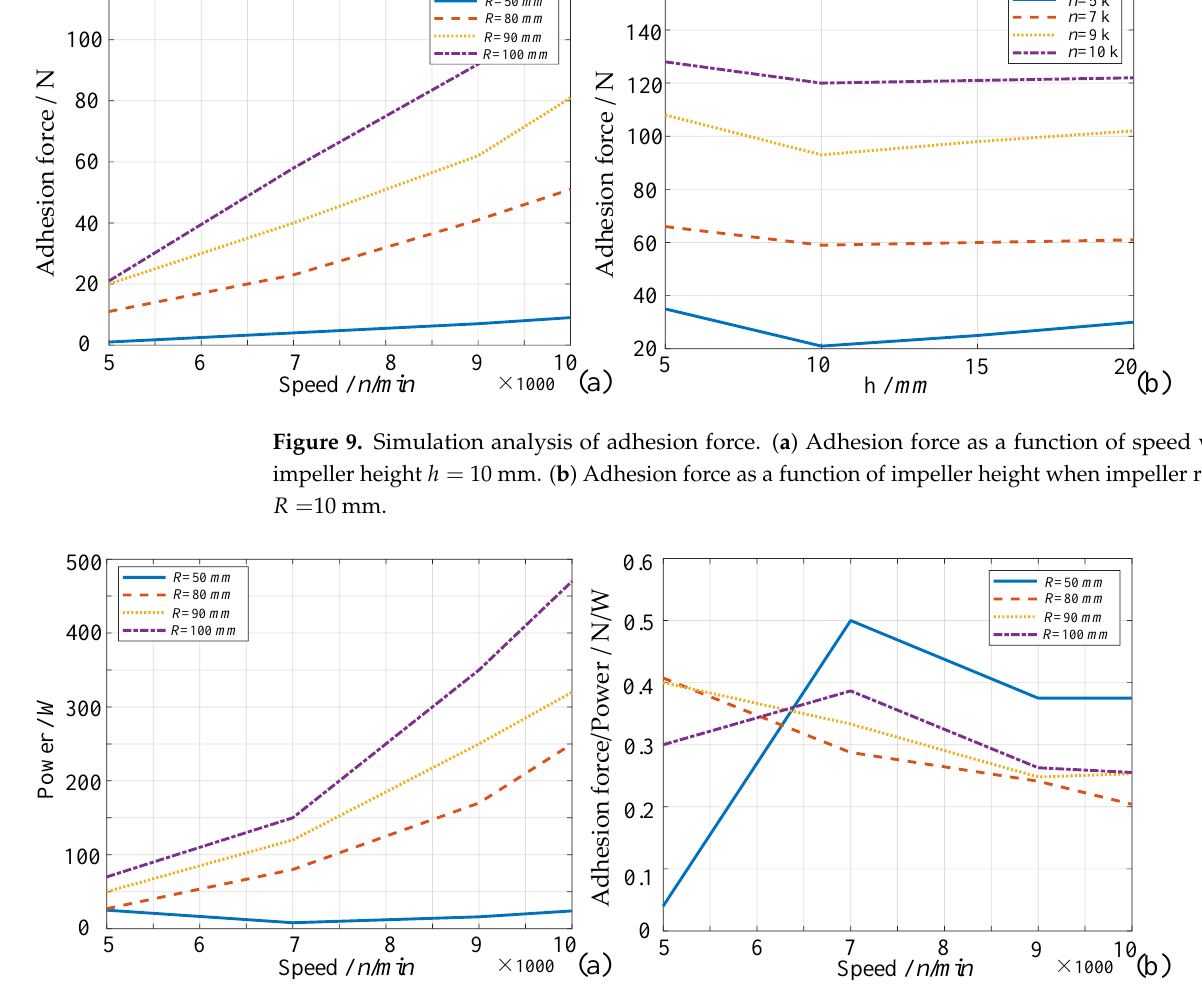
Figure 11. Meshed model of the impeller. In the dynamic simulation, the impeller maximum total deformation in the first and fifth modes are shown in Figures 12 and 13. From the simulation, it can be seen that there will be about 1 mm total deformation in the structure; however, by increasing the contact area, one connector between the motor and the impeller can be designed. A 5 mm-thick connecting flange can increase the diameter from 5 to 40 mm, and the defection will re- duce to <0.2 mm.